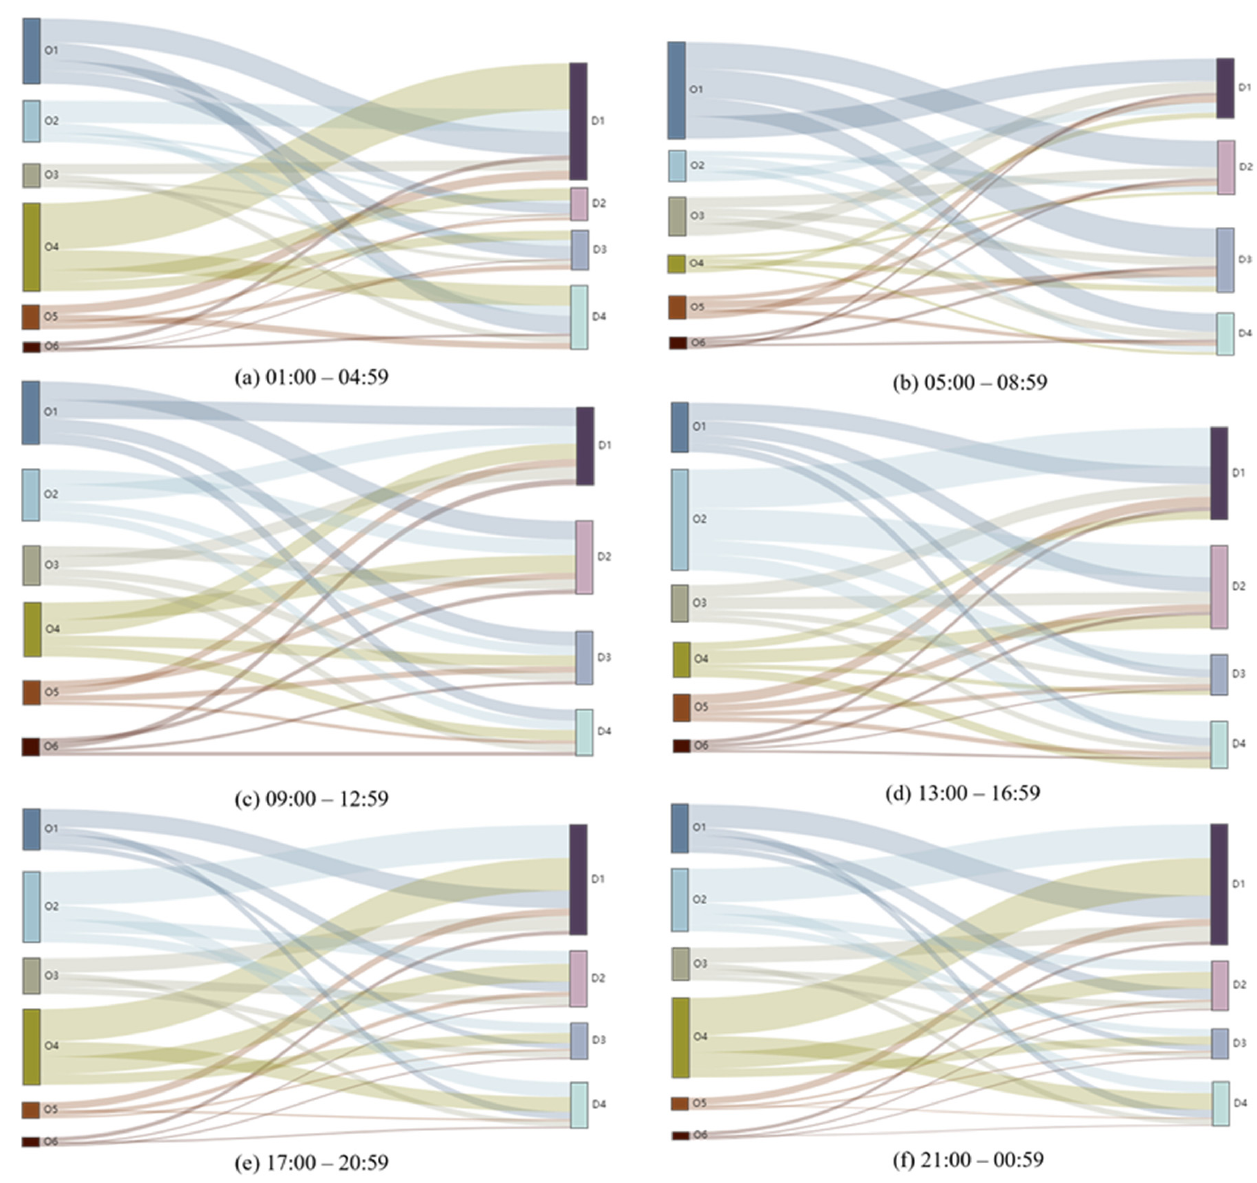
Figure 9. Activity transitions from origins to destinations at different periods. As shown in Figure 9a, many flows change from Recreation-related activity to Home- related activity during 01:00–04:59. Combination Figure 10a, shows that the activity se- mantic flow of “Recreation–Home” is mainly concentrated from Beijing Workers’ Sports Complex to Shifoying, Dawanglu and Shuangjing, and from Sanlitun to Dawanglu, Hu- fangqiao and Shuangjing. Meanwhile, working overtime is discovered in this period, around Liangmaqiao and Chaowai. After work, individuals return home, mainly from Liangmaqiao to Shuangjing and from Chaowai to Baiziwan. Partial “Home–Home” flow occurred from Beixinqiao to Xueyuanlu, where there might have been a social event or